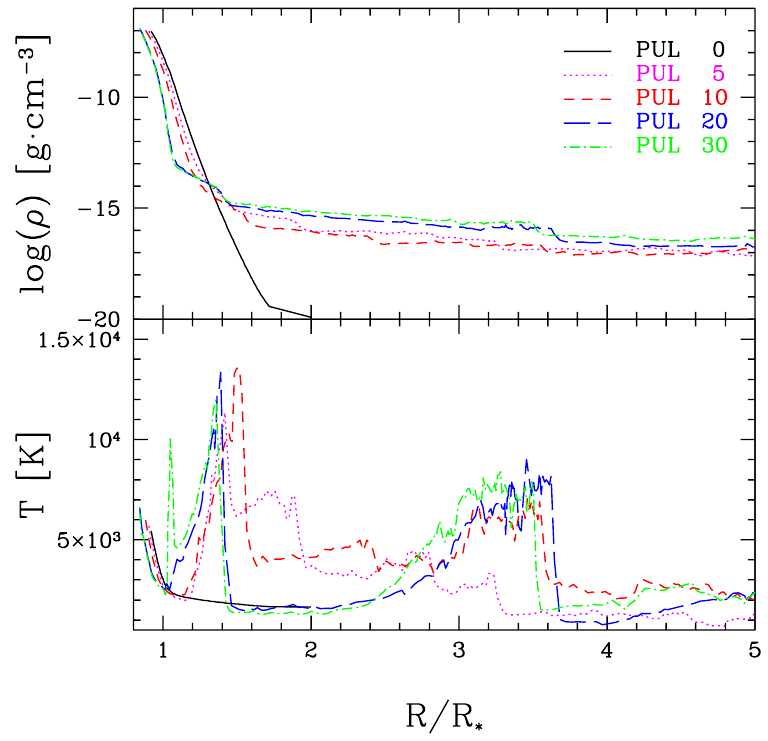
Figure 2. Density profiles (upper panel) and temperature profiles (lower panel) as a function of the radius coordinate for different